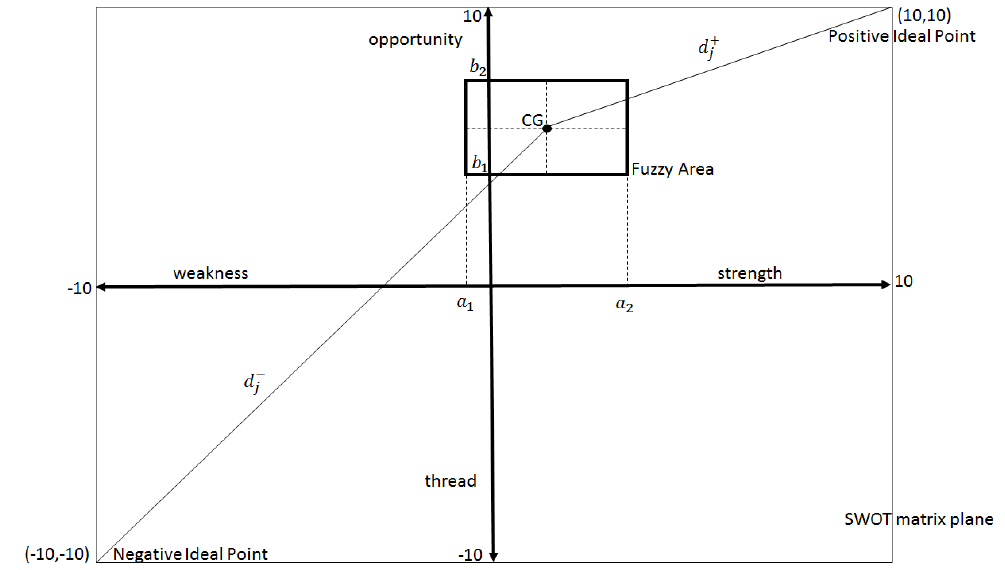
Figure 6. Center of gravity and coefficient of closeness.